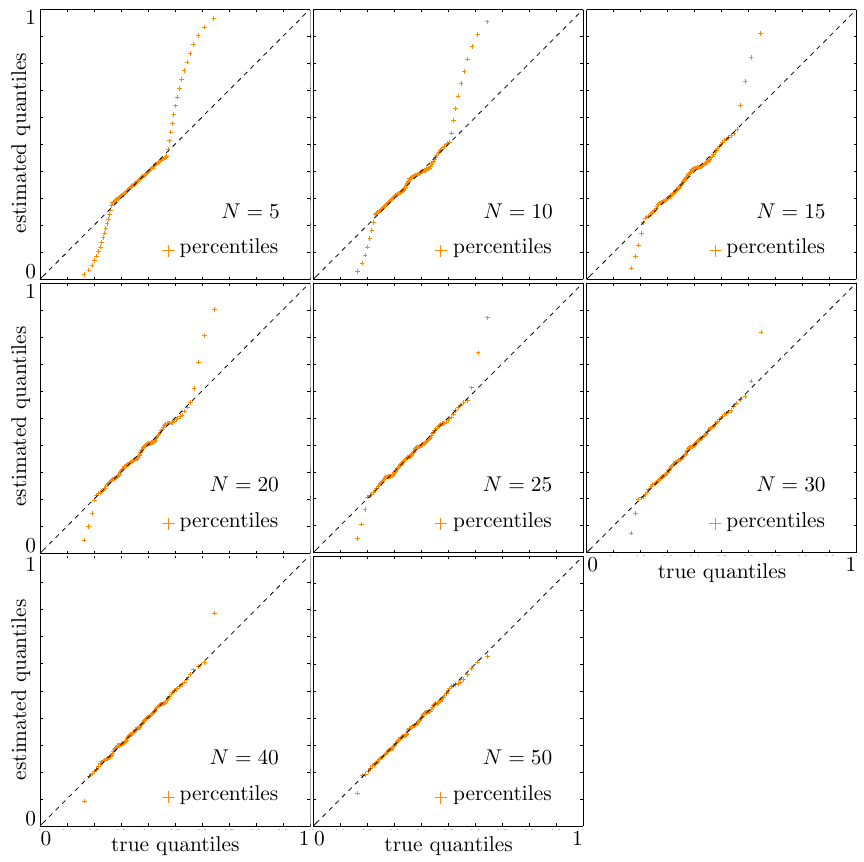
Fig. 4. Quantile-quantile plots. On the x-axis there are the true values of the quantiles of g , on the y-axis their estimates given by the SQ. The orange daggers represent the percentiles, from 1 to 99. If a dagger is close to the dashed line y = x , the SQ gives a good estimate of the corresponding percentile. Different graphs refer to different numerosities of the